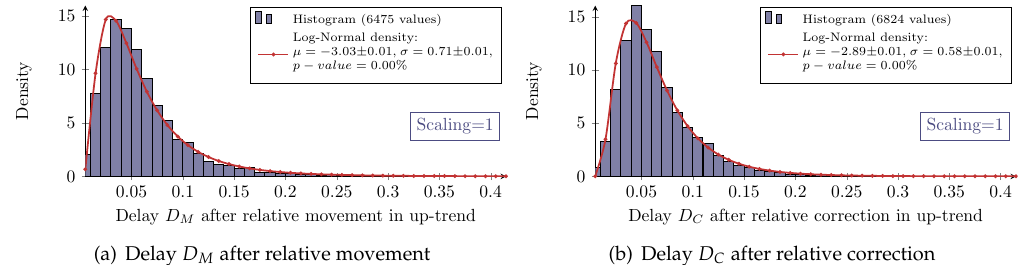
Figure 11. ( a ) Measured and log-normal fit density of the relative delay after a relative movement M (see 2) and ( b ) after a relative correction C (see 3) in an up-trend with scaling one for S&P100 stocks. The data are visualized with a histogram from zero to one with a bin size of 0.01.